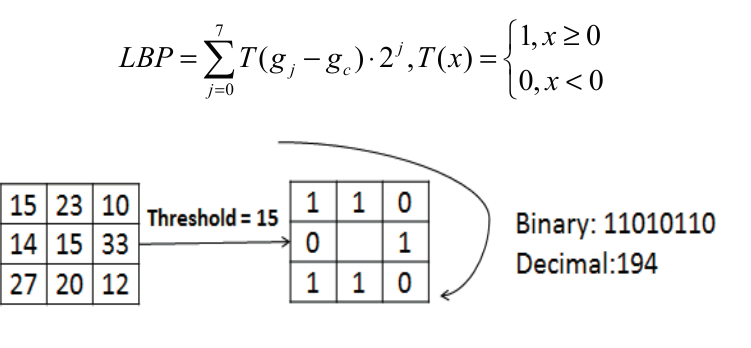
Figure 1. The basic LBP